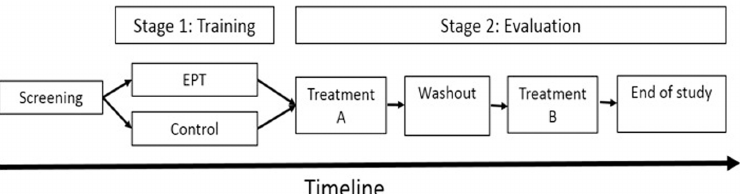
Fig 2. Study design. The study included 2 phases: An unblinded parallel-design training stage, and a double-blind crossover evaluation stage.